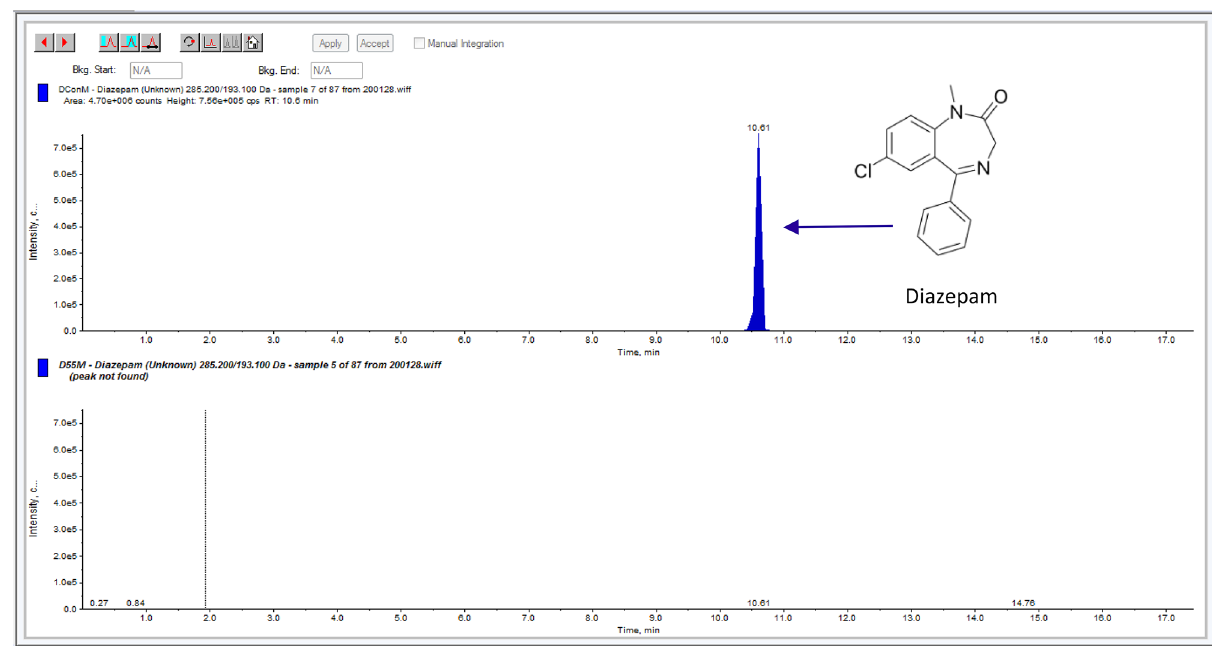
Figure 2. SafeMedWaste denatures diazepam waste generated by a manufacturing facility. An LC–MS chromatogram of the 5 mg/mL diazepam waste stream sample before treatment with SafeMedWaste is shown in the top panel, whereas a chromatogram of the same waste sample after treatment with SafeMedWaste is shown in the bottom panel. After treatment with SafeMedWaste, the diazepam peak was below the limit of detection of 1